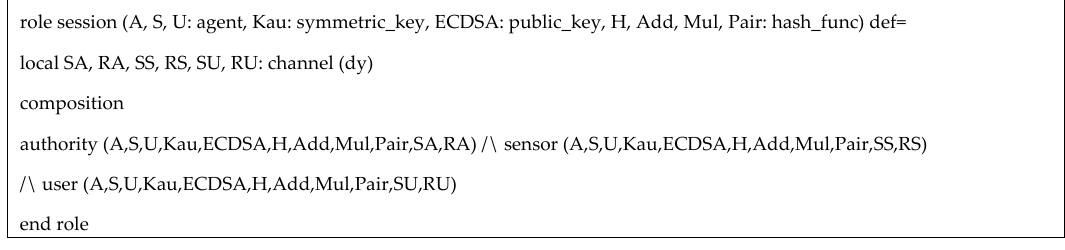
Figure 6. HLPLS specification of session role.